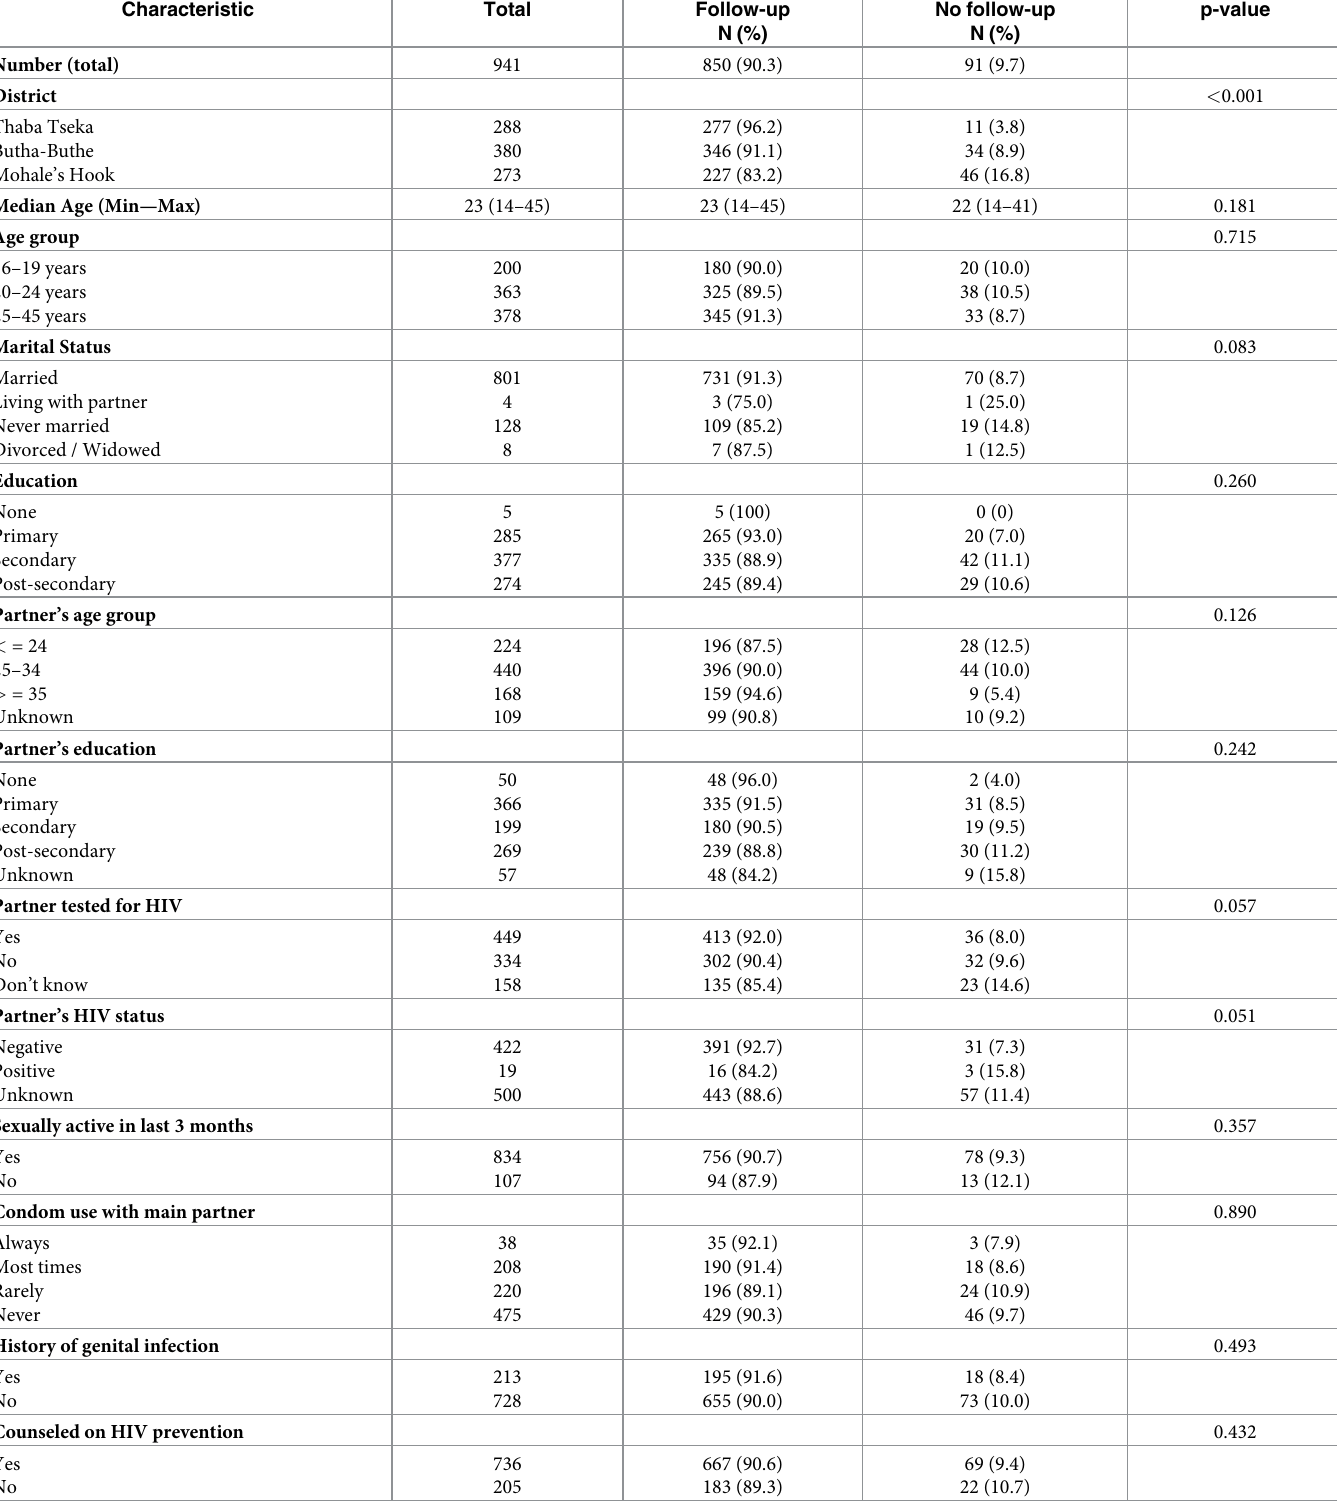
Table 1. Baseline characteristics of all HIV negative women enrolled in study (n = 941) by presence of follow-up HIV test.